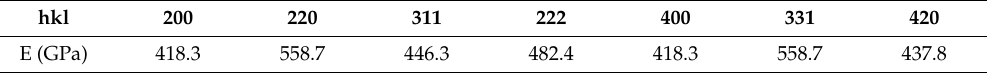
Figure 4. Relationship between the values of residual stress and the time of coating deposition, B – coating thickness. Table 4. Used Young’s modulus (E) values for various crystallographic directions of ZrN.